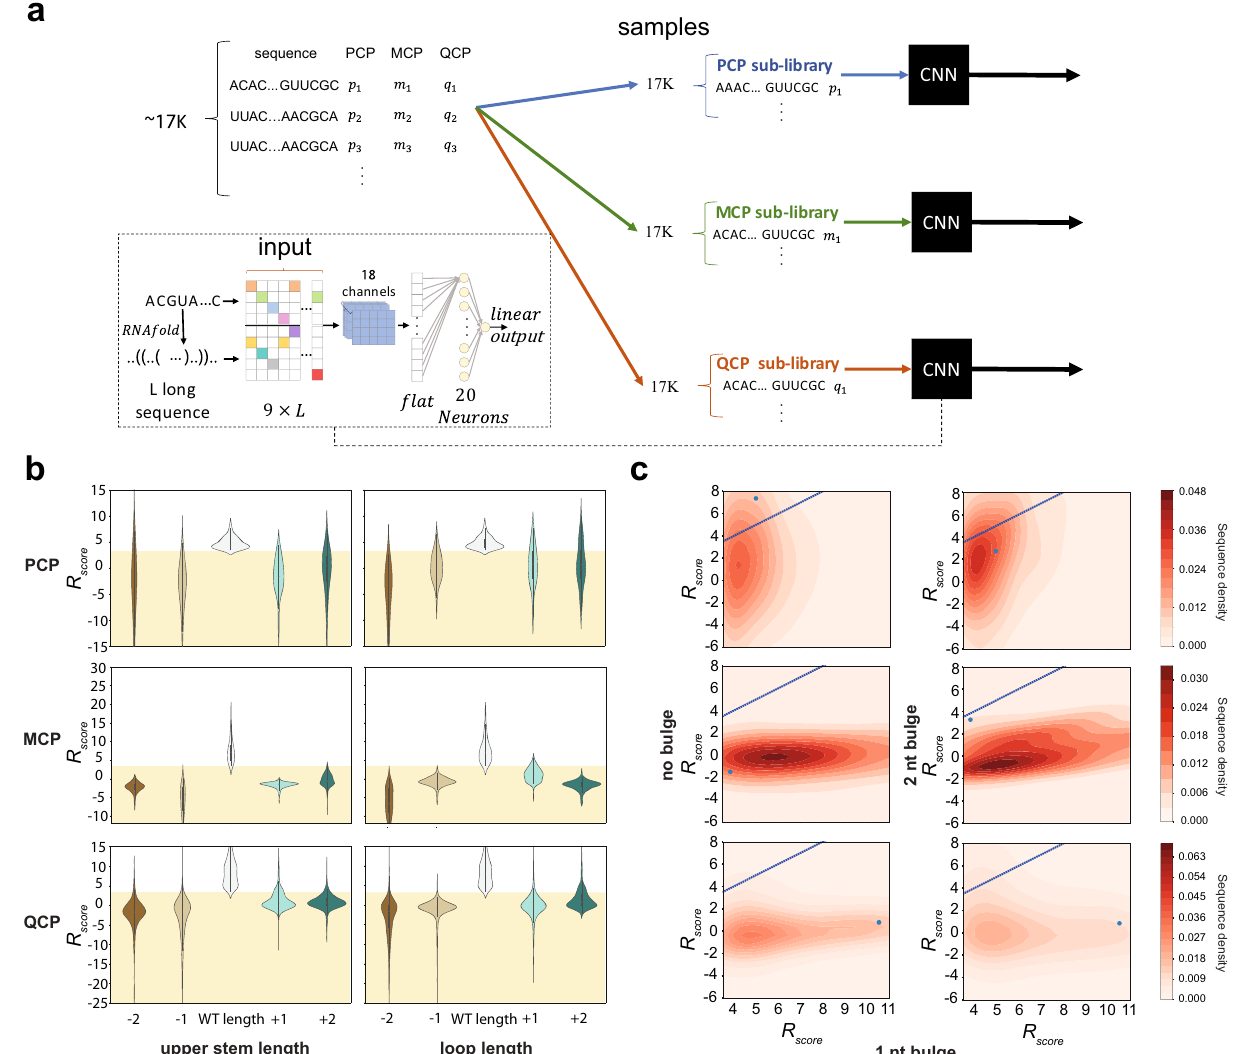
Fig. 4 Analysis of MCP, PCP, and QCP RNA-binding structure preferences. a A scheme for the data preparation and neural network architecture (inset) used for the protein-speci fi c CNN model based on the whole-library. We generated various binding sites with a prede fi ned structure different from the wild type and used the whole-library models to predict their responsiveness score. b Predicted R score distributions for binding sites that differ in the length of the upper stem (left) or the loop (right) for PCP (top row), MCP (middle row), and QCP (bottom row). Stem and loop lengths were varied by ±2 base-pairs and nucleotides, respectively. Yellow shade corresponds to non-binding R score values. c Density maps for predicted R score for either no bulge (left-column) or a 2-nucleotide bulge (right-column) mutation of a wild-type-like structure for PCP-response (top row), MCP-response (middle row), and QCP-response (bottom row). Source data are provided as a Source data fi le. Blue dots correspond to wild-type